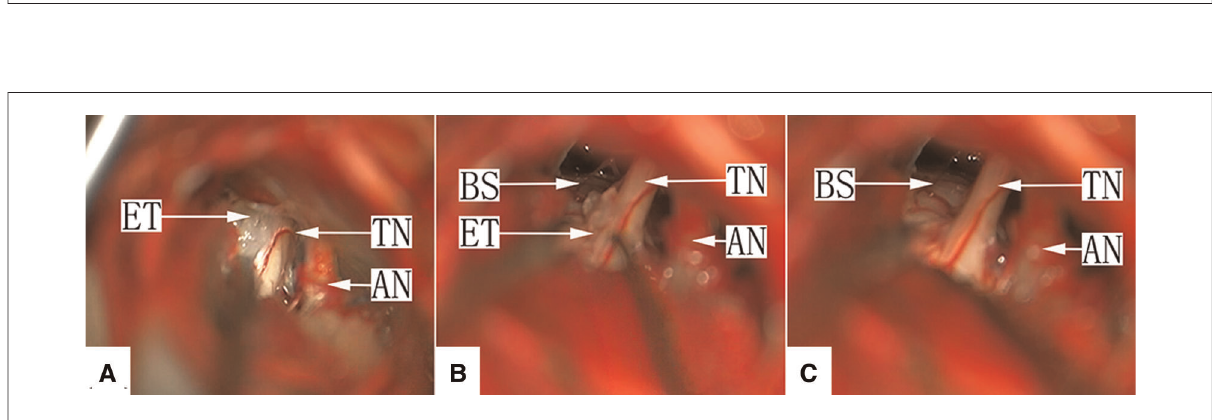
FIGURE 1 The 3D-FIESTA and 3D-TOF magnetic resonance sequence of TGN secondary to EC patients with offending arteries. Tumors of the epidermoid cyst, trigeminal nerve and offending artery are indicated by the arrows. ET, epidermoid tumor; TN, trigeminal nerve; OA, offending